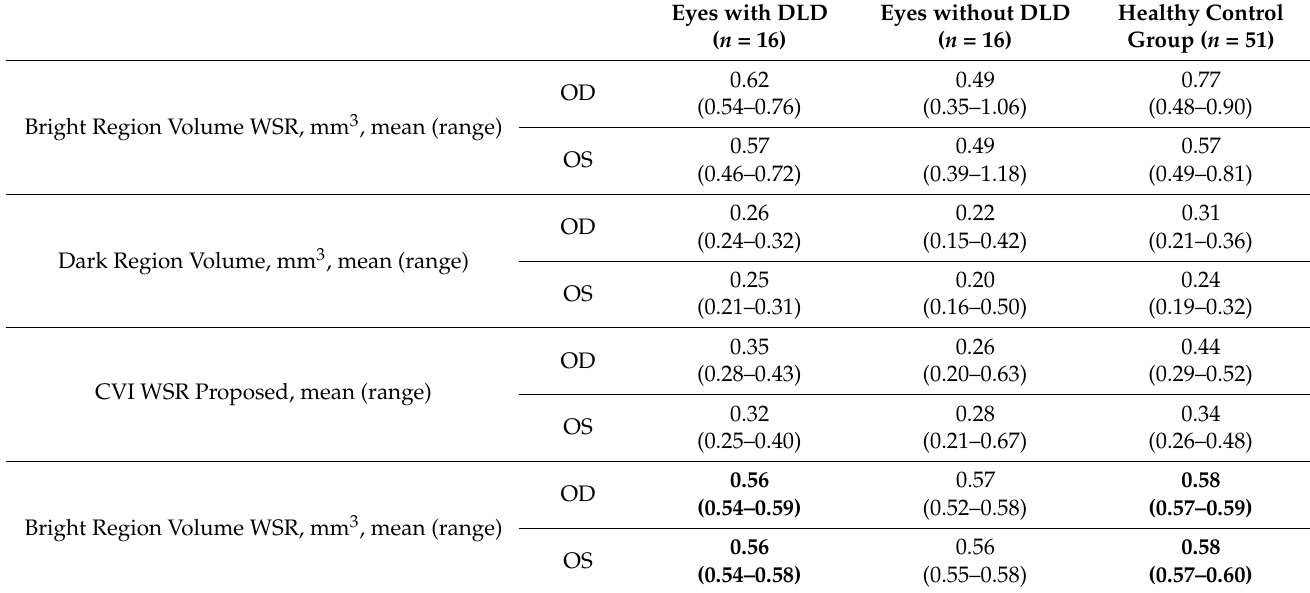
Table 3. Choroid volume analysis and choroidal vascularity indices. Significant differences shown in bold type.